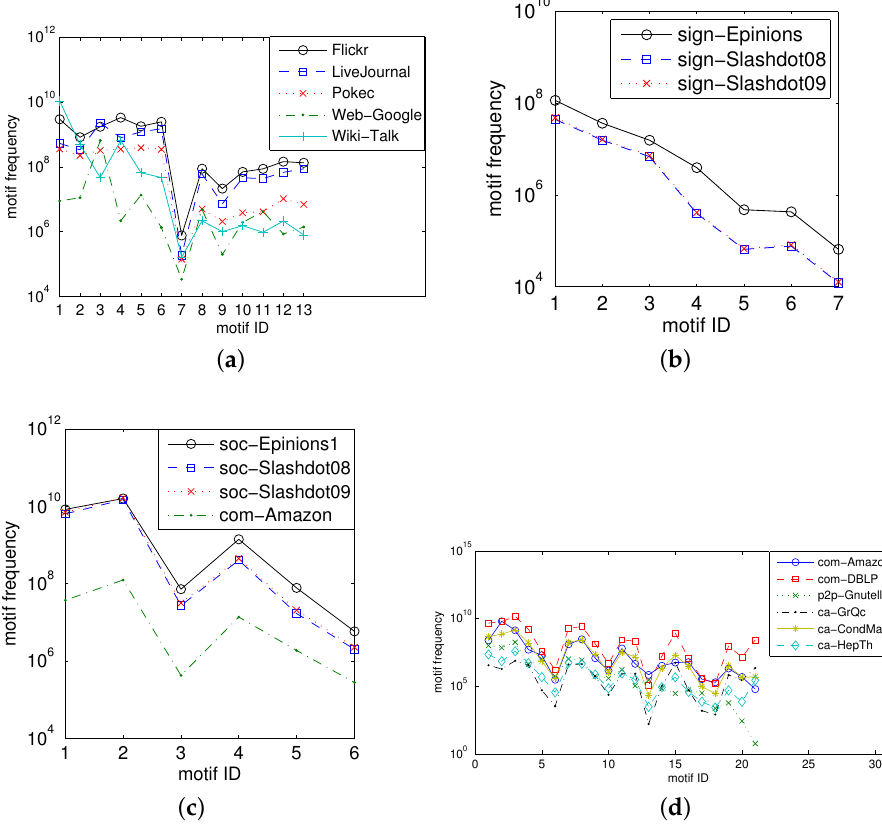
Figure 6. Real values of motif frequencies: ( a ) three-node directed motifs; ( b ) three-node signed motifs; ( c ) four-node undirected motifs; ( d ) five-node undirected